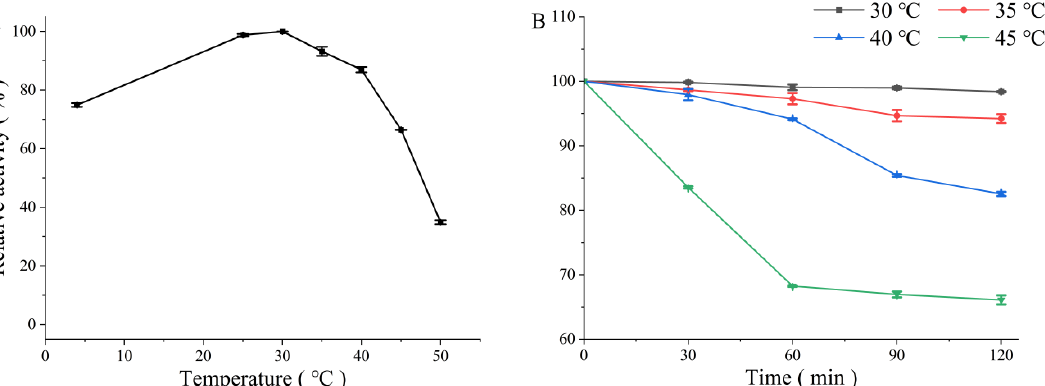
Figure 3. Effects of temperature on the enzymatic activity of the novel alginate lyase (PMD). ( A ) Activities of PMD under different temperatures (ranging from 4 °C to 50 °C); ( B ) thermostability of PMD.